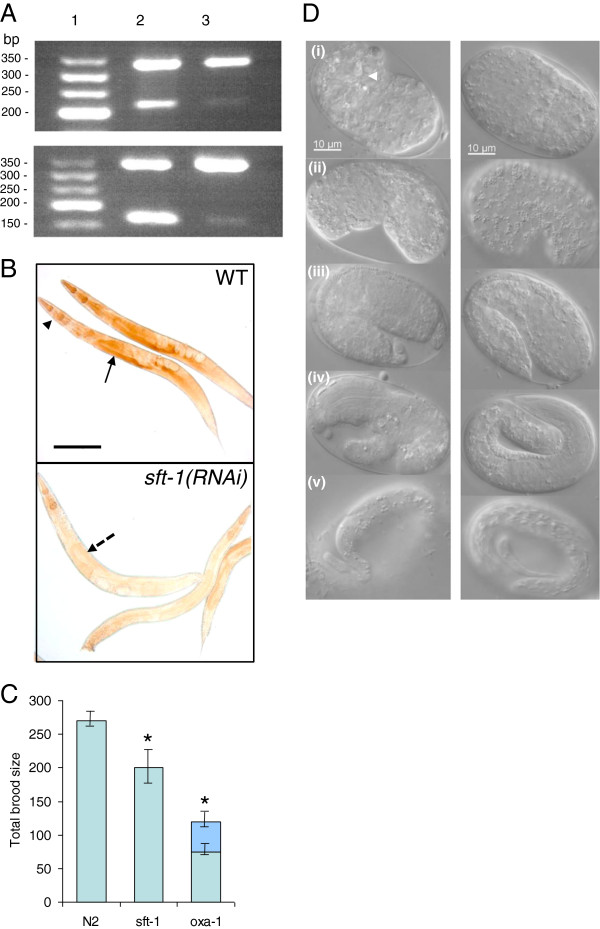
sft-1 or oxa-1 RNAi results in reduced gene expression, COX staining and brood size. A: RT-PCR of oxa-1 and sft-1 to compare mRNA levels. Lane 1, 50 bp DNA ladder. Upper panel: Lane 2, RT-PCR products from WT animals. Upper band (350 bp) corresponds to eft-2 mRNA (internal control), lower band (220 bp) corresponds to sft-1 mRNA. Lane 3, RT-PCR products from the progeny of animals injected with sft-1 dsRNA. sft-1 expression is greatly reduced. Lower panel: Lane 2, RT-PCR products from WT animals. Upper band (350 bp) corresponds to the eft-2 internal control, lower band (164 bp) corresponds to oxa-1 mRNA. Lane 3, RT-PCR products from the progeny of animals injected with oxa-1 dsRNA. oxa-1 expression is greatly reduced. B: COX staining in WT and sft-1(RNAi) animals. In WT, COX staining is particularly prevalent in the pharynx (black arrowhead) and germ line (black arrow), tissues that have high energy demands. In sft-1(RNAi) animals, COX staining is greatly reduced (photomicrographs taken using identical exposure times), especially in the germ line (dotted arrow). Scale bar, 100 μm. C: Brood size of WT animals injected with sft-1 or oxa-1 dsRNA compared with control animals injected with TE only (labeled N2). Both sft-1 and oxa-1 RNAi result in a significantly reduced brood size compared with controls (*P <0.005). The darker shaded area of the bar corresponding to oxa-1(RNAi) represents the proportion of dead embryos. Error bars denote the standard error of the mean (SEM). D: Embryonic lethality induced by oxa-1 RNAi. Left hand panel: oxa-1(RNAi) embryos, right hand panel: WT embryos at equivalent stages. Defects can be seen throughout embryogenesis, including necrotic regions in early embryos (i, white arrowhead), morphological defects at the “bean” stage (ii), elongation defects at the “comma” stage (iii) and later (iv, v). Posterior defects are particularly pronounced.